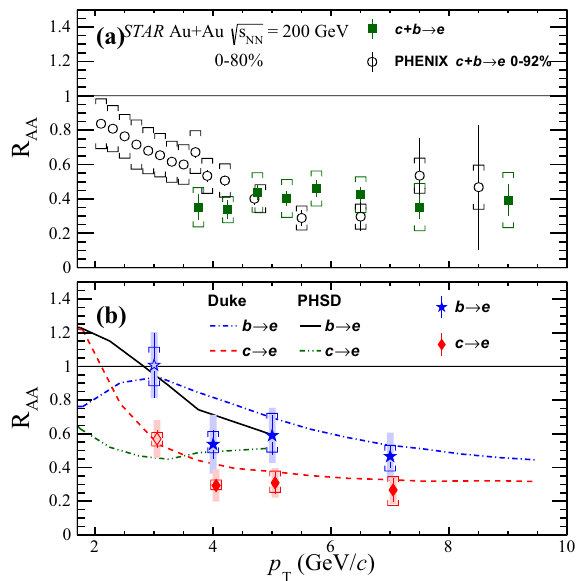
Fig. 10 a The R AA ratio of bottom- to charm-decay electrons in inter- Fig. 9 a The inclusive heavy flavor electron R incl . (green squares) and √ AA s NN = 200 GeV. b The vals of electron p T in Au+Au collisions at the measurement from PHENIX (open circles) [61] in intervals of elec- √ R CP ratios of bottom-decay electrons to that of charm-decay electrons s NN = 200 GeV. b The measured tron p T in Au+Au collisions at √ s NN = 200 GeV. in intervals of electron p T in Au+Au collisions at R AA for bottom- (blue stars) and charm-decay (red diamonds) elec- √ The red diamonds show the ratios of R CP ( 0 − 20% / 40 − 80% ) , and the s NN = 200 trons in intervals of electron p T in Au+Au collisions at blue circles show the ratios of R CP ( 0 − 20% / 20 − 40% ) . In all panels the GeV. The open markers indicate values calculated using the PHENIX error bars and the brackets show statistical and systematic uncertain- R incl . . In all panels the error bars show the statistical uncertainties, AA ties, respectively. The Duke [31] and PHSD [62,63] models are shown and the brackets show the systematic ones. The shaded boxes on the as the various lines. The null hypothesis calculations are shown as the data in b show the uncertainty due to R incl . . Additional 8( ⊕ 8)% and AA shaded bands (see text for details). R AA and R CP ( 0 − 20% / 40 − 80% ) 8.1%uncertaintiesfromthe N coll . calculations( p + p luminosity)forthe points are plotted along the x -axis at their respective bin centers and STAR and PHENIX R AA , respectively, are not shown. The Duke [31] R CP ( 0 − 20% / 20 − 40% ) is shifted by 75 MeV/ c for and PHSD [62,63] models are shown as the various lines in b . Data points are plotted along the x -axis at their respective bin centers, except the charm-decay electron data in b , which are offset by 50 MeV/ c for clarity